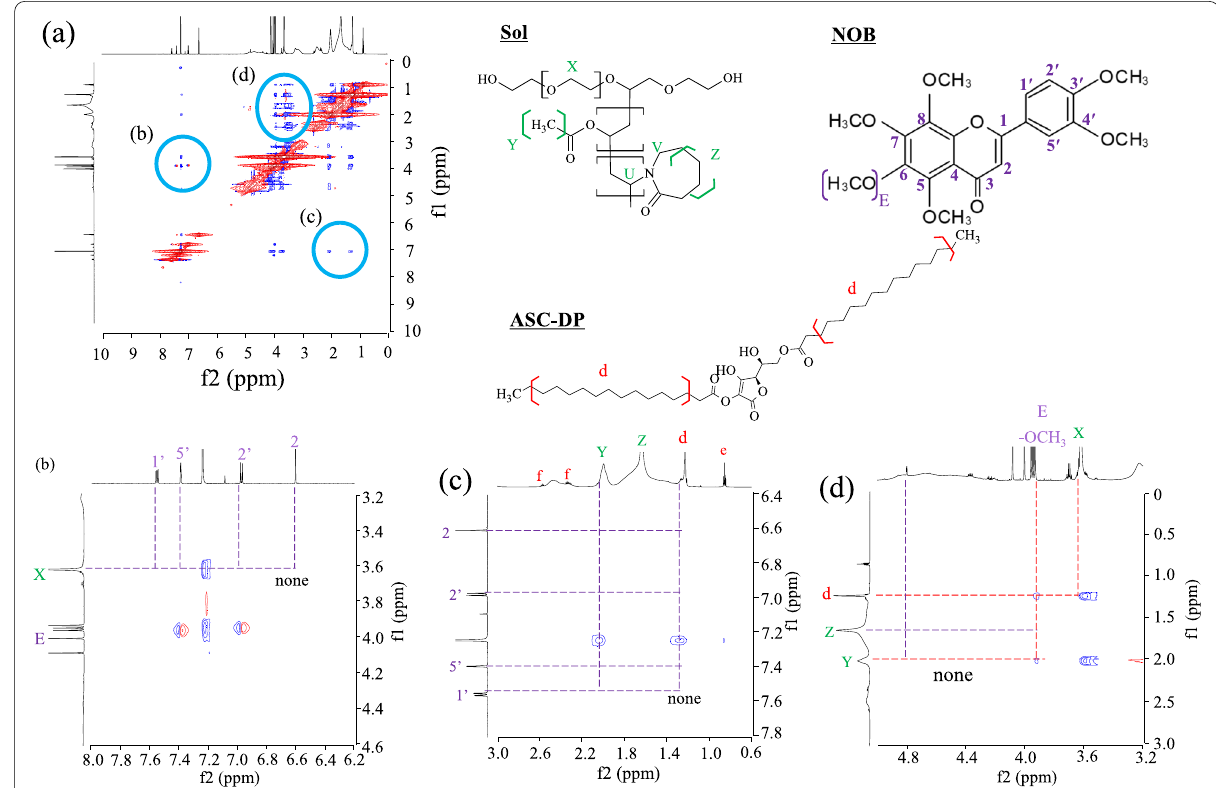
Fig. 6 1 H- 1 H ROESY NMR spectrum EVP (Sol/ASC-DP/NOB 8/1/1) in CDCl 3 . a f1 is 0–10 ppm and f2 is 0–10 ppm; b f1 is 3.2–4.6 ppm and f2 is = 6.2–8.0 ppm; c f1 is 6.4–7.8 ppm and f2 is 0.6–3.0 ppm; d f1 is 0.5–3.0 ppm and f2 is 3.0–3.4